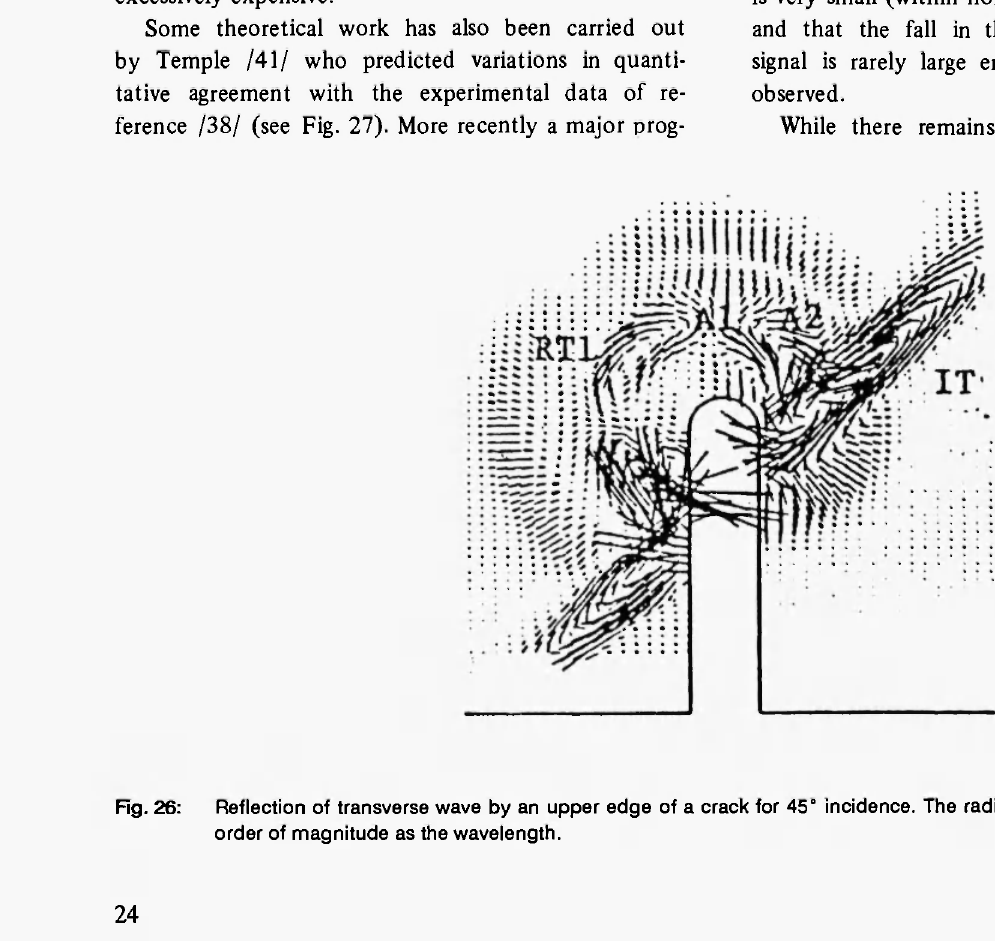
Fig. 26: Reflection of transverse wave by an upper edge of a crack for 45° incidence. The radius of the round edge has the same order of magnitude as the